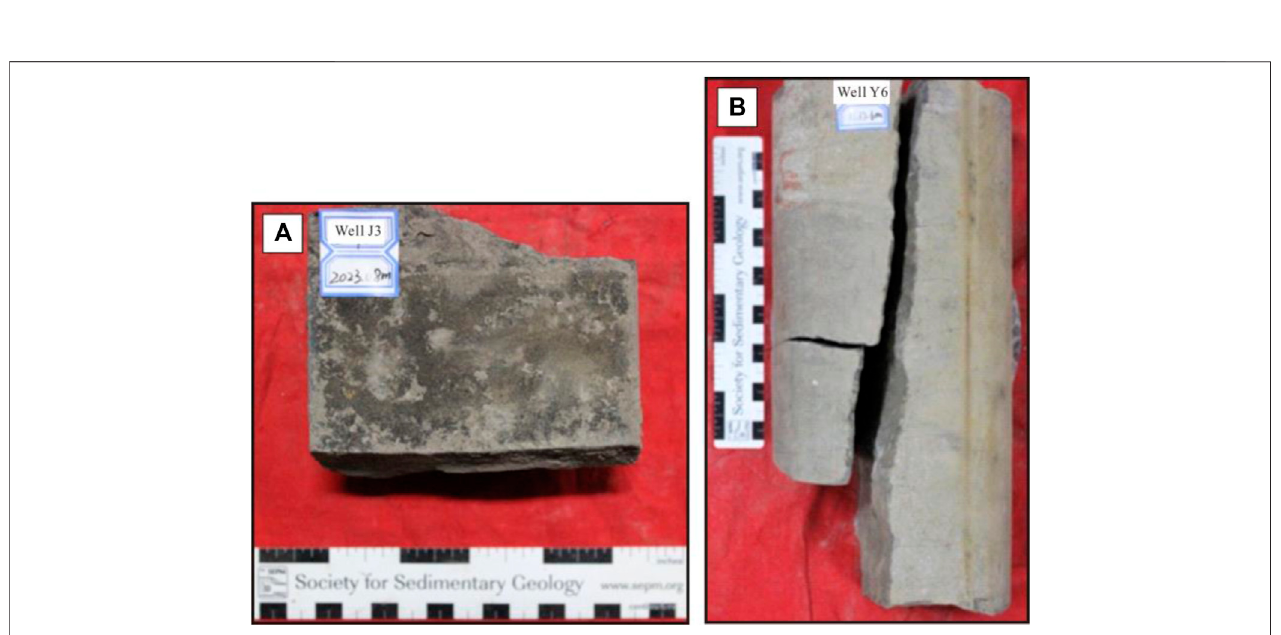
FIGURE 8 | Developmental characteristics of core fractures in the target layers. Notes: (A) High-angle shear fracture (Well J3, Chang 8 Member); (B) High-angle tensile fracture (Well Y6, Chang 6 Member).